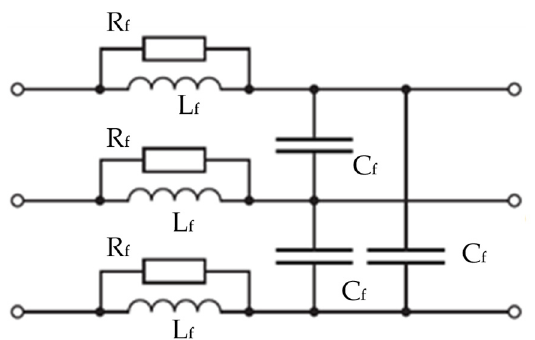
Figure 11. Low-pass input filter.